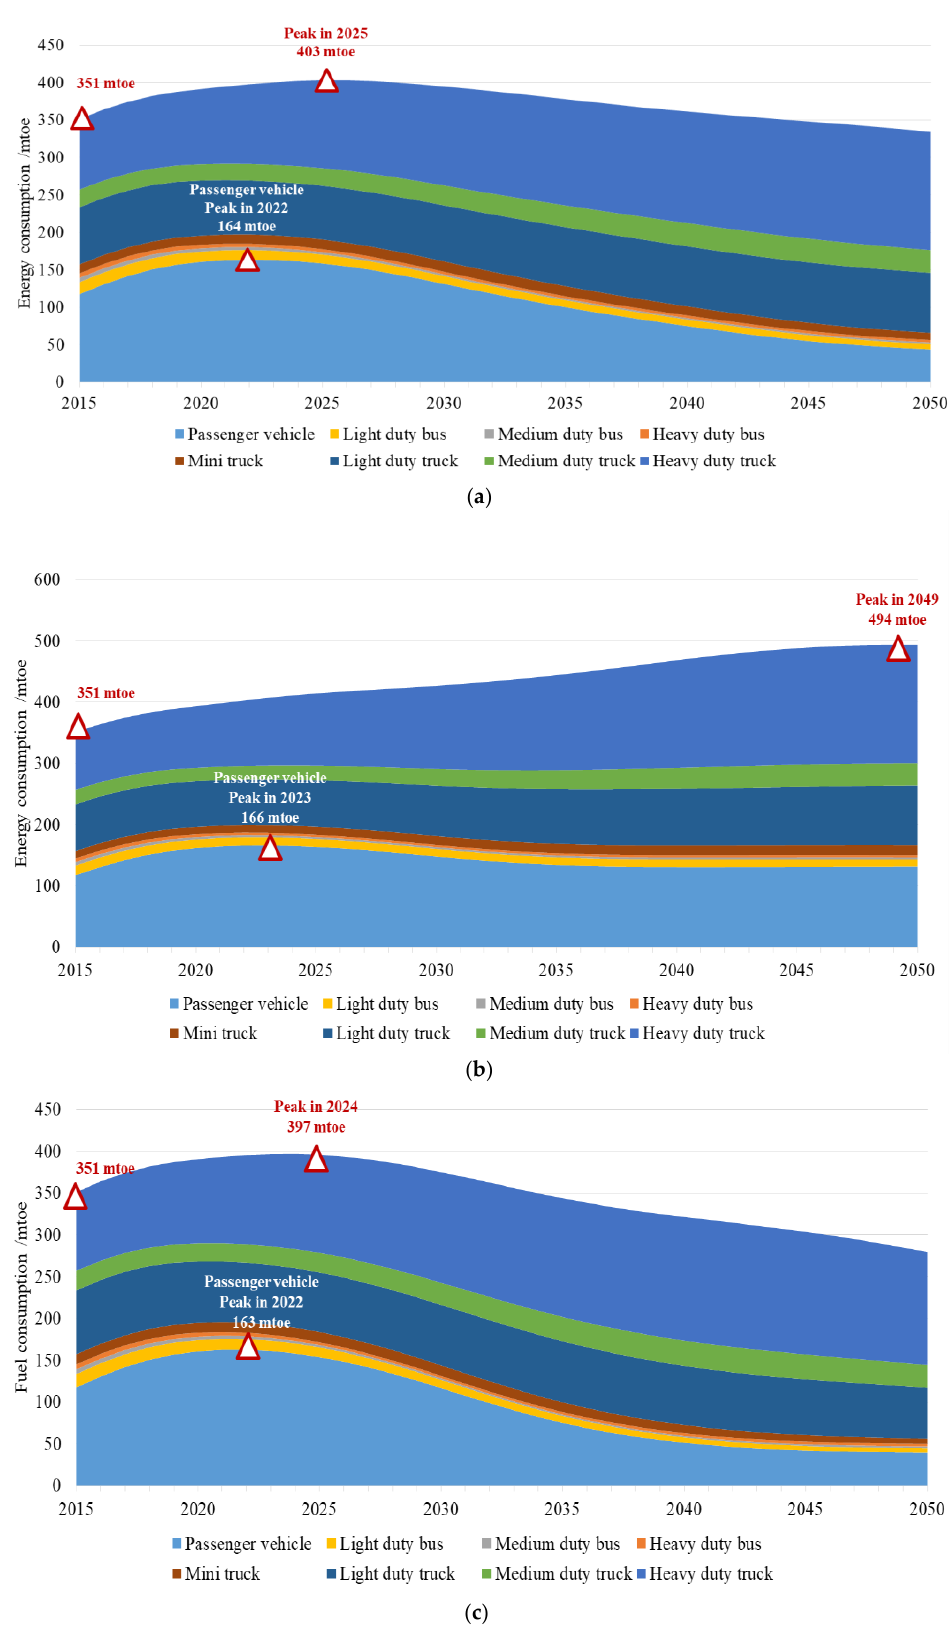
Figure 8. Energy consumption under BAU, Conservative and Optimistic Scenarios. ( a ) BAU Scenario; ( b ) Conservative Scenario; ( c ) Optimistic Scenario.